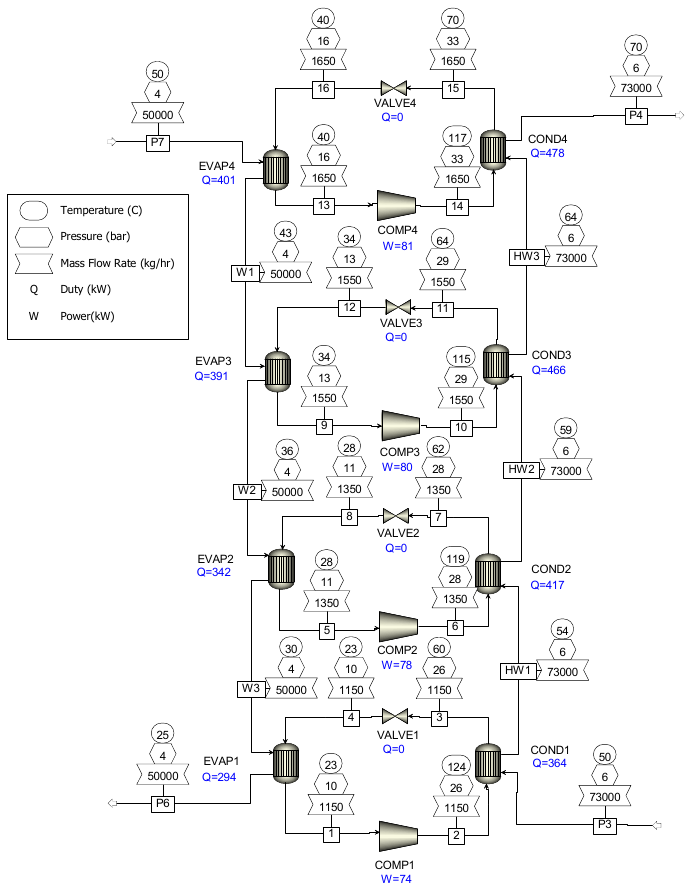
Figure 4. The scene of four series-connected high-temperature heat pumps with the results of computer simulation using the Aspen Plus software package.